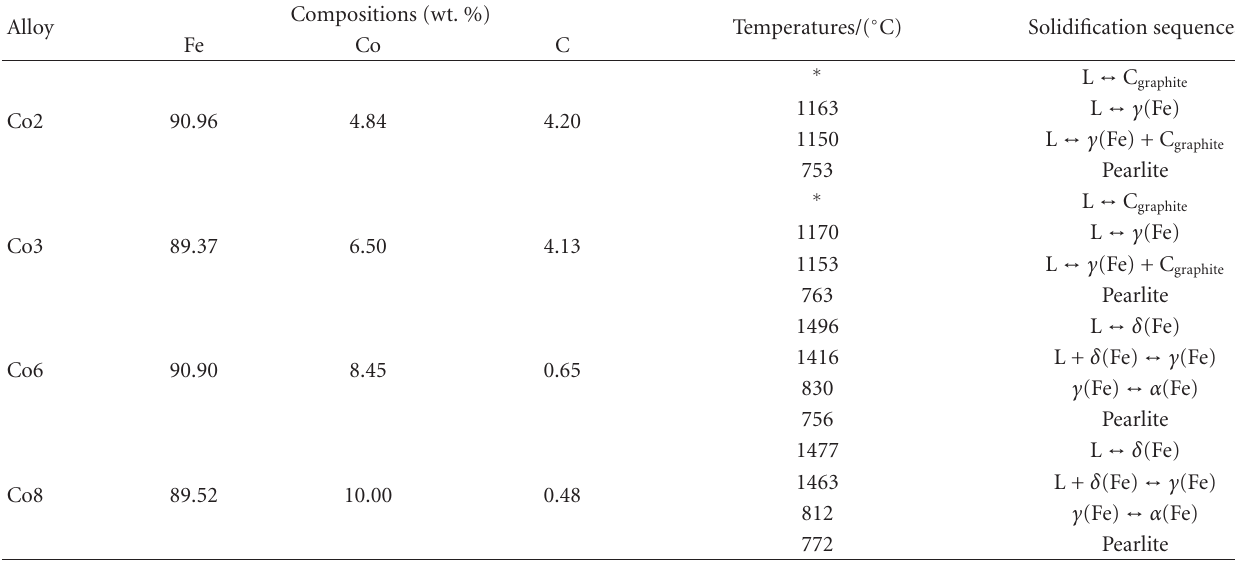
Table 1: Compositions, transformation temperatures, and solidification sequences of FeCoC studied alloys. ( ∗ Temperature not detected by our di ff erential thermal analysis apparatus limited to temperature lower than 1550 ◦ C).